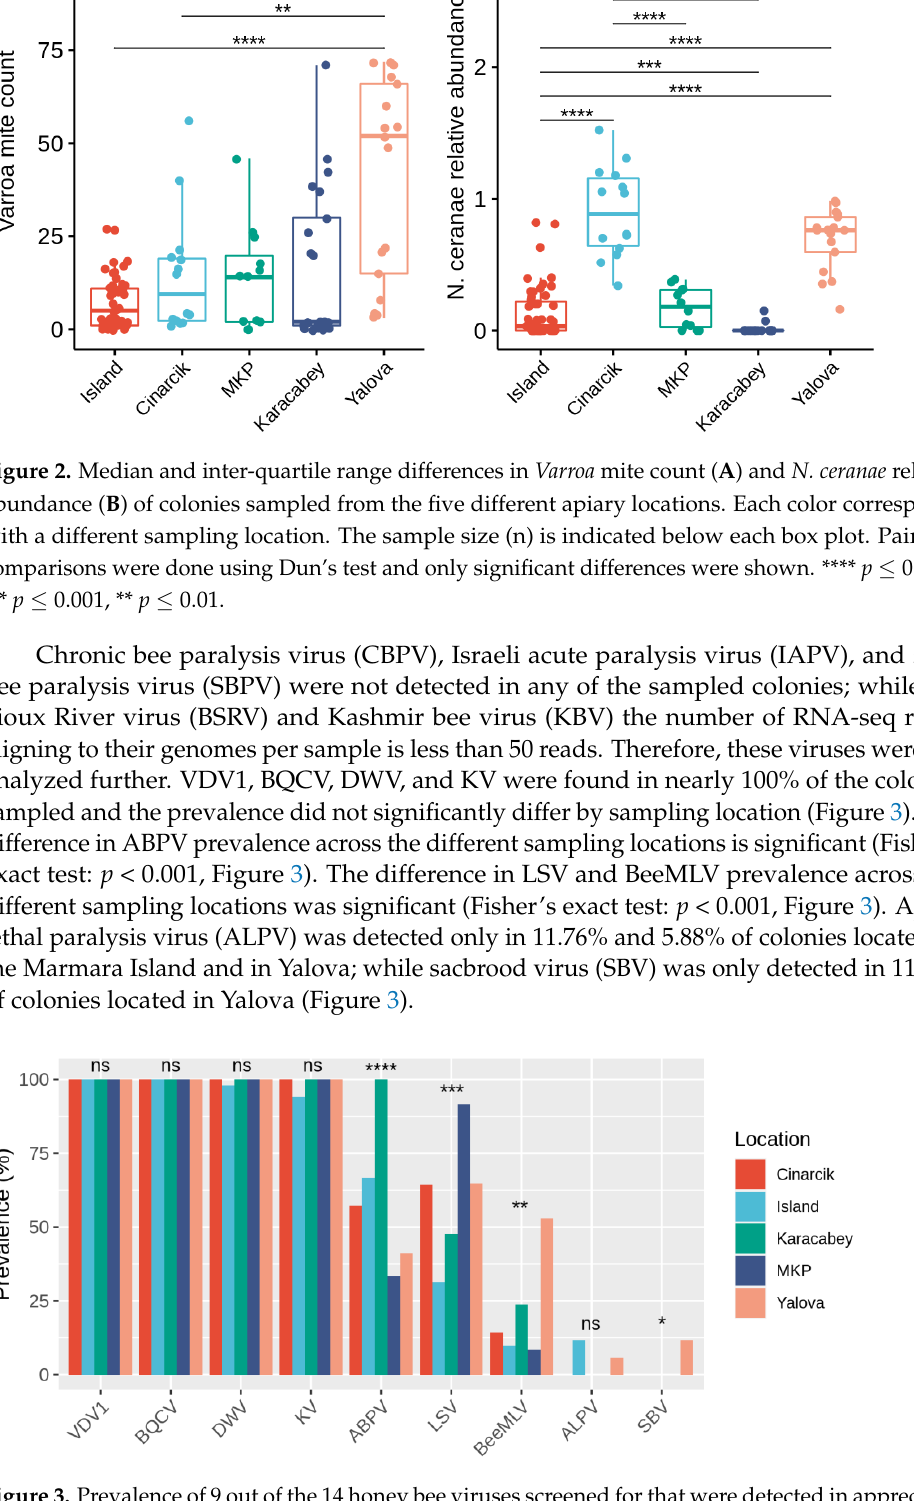
Figure 3. Prevalence of 9 out of the 14 honey bee viruses screened for that were detected in appreciable amounts. Each color represents one of the five apiary sampling locations. Statistical significance was determined using Fisher’s exact test. **** p ≤ 0.0001, *** p ≤ 0.001, ** p ≤ 0.01, * p ≤ 0.05, not significant (ns) p >